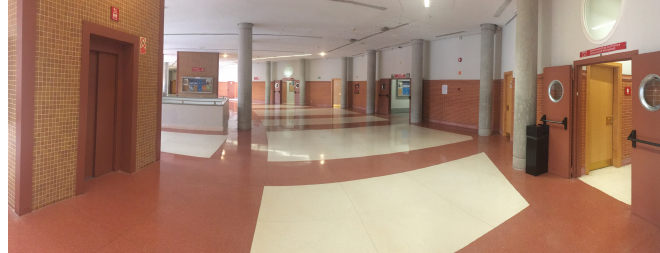
Figure 25. Test Bed: Indoor scenario.